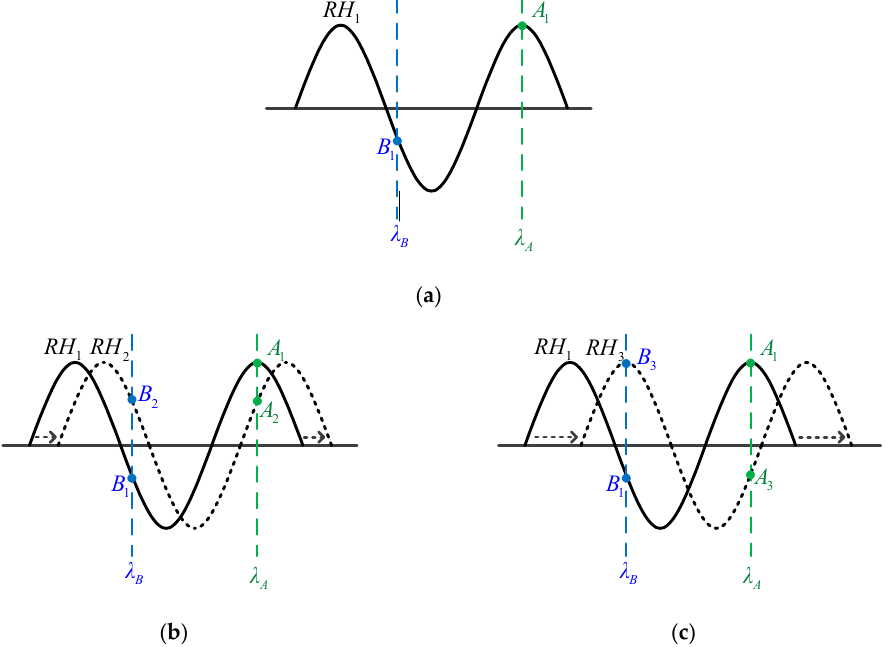
Figure 6. Schematic diagrams of spectrum shift monitoring on two wavelengths: ( a ) initial state; ( b ) right shift within feasible detecting range; ( c ) when the spectrum shift has reached its